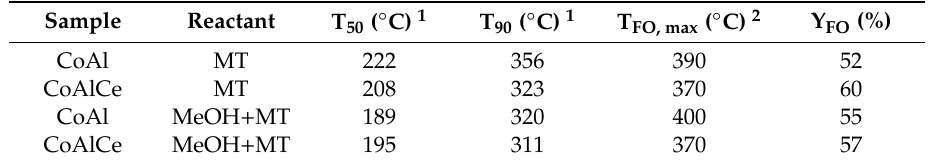
Figure 9. Products and reaction intermediates of methanethiol oxidative desulfurization over CoAl and CoAlCe catalysts. Table 6. Comparison of light-off temperatures (T 50 and T 90 ) and formaldehyde yields in the reactions of methanethiol and a mixture of methanol and methanethiol over CoAl and CoAlCe catalysts.